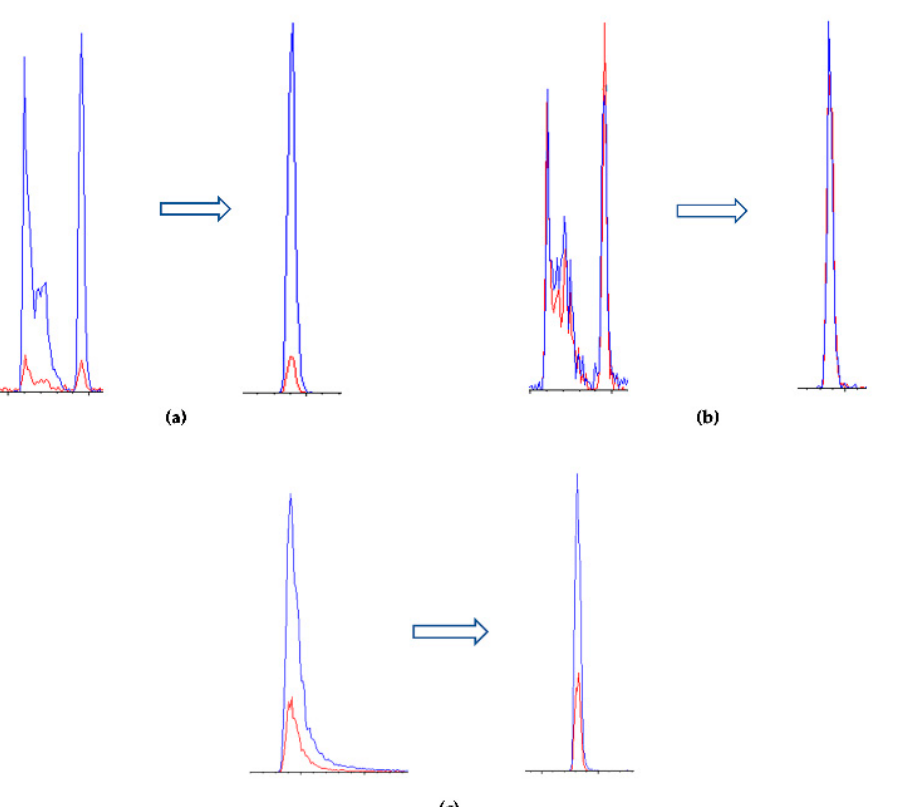
Figure 3. Improvement of the extracted ion current (XIC) of ( a ) N-methylcytisine, ( b ) cytisine, and ( c ) sparteine by comparison of the relative XICs resulting from the use of formic acid (left) and HFBA (right) in mobile phases using the C18-PFP column. All analytes were tested at a concentration of 20 ng mL − 1 .